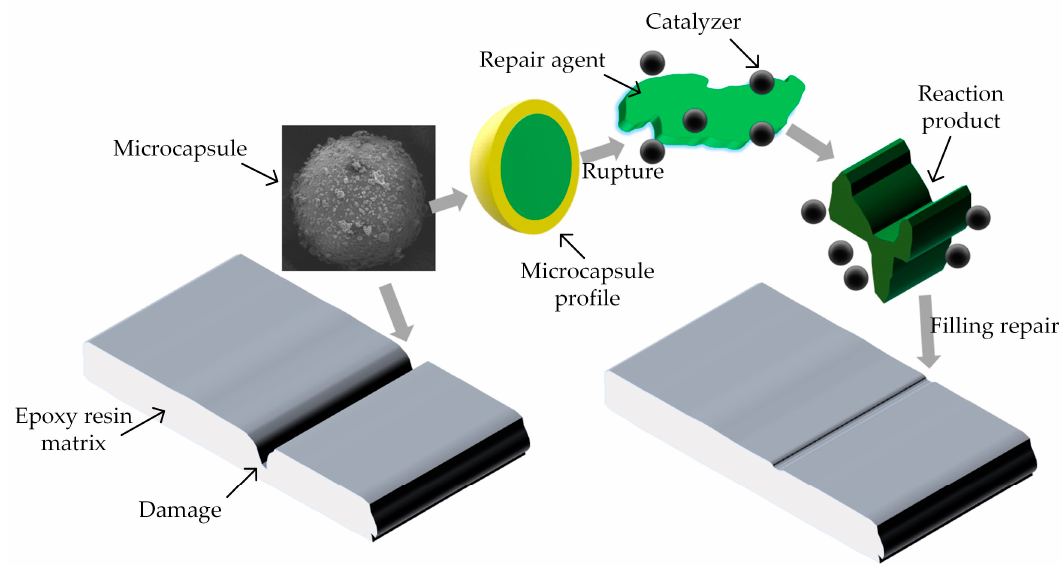
Figure 3. Repair behavior of composite.